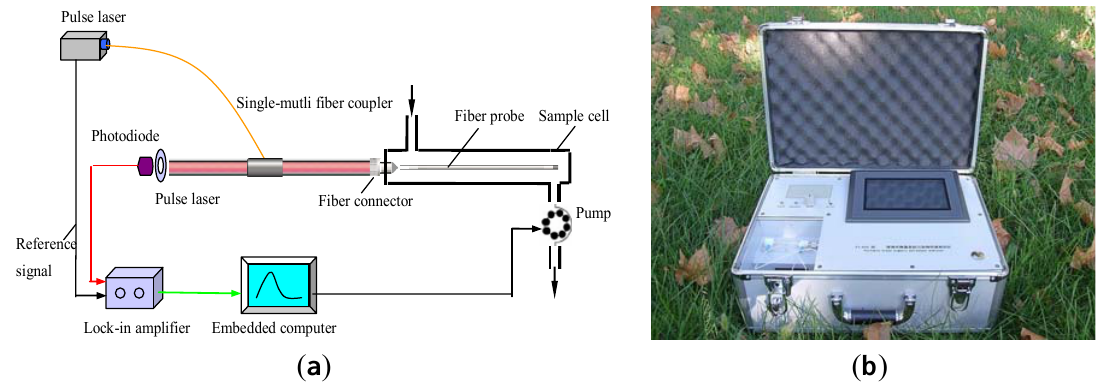
Figure 2. Schematic set-up of the portable evanescent wave optical fiber biosensor (EWAB): ( a ) principle scheme of the portable optical fiber biosensor and ( b ) the portable platform. Reprinted with permission from